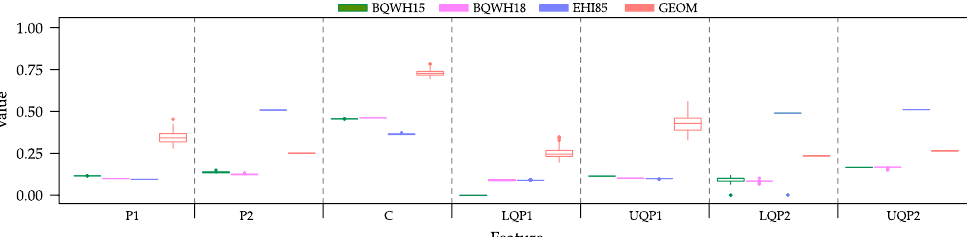
Figure 2. Distribution of the values of the seven features that characterize the CSP instances, grouped by